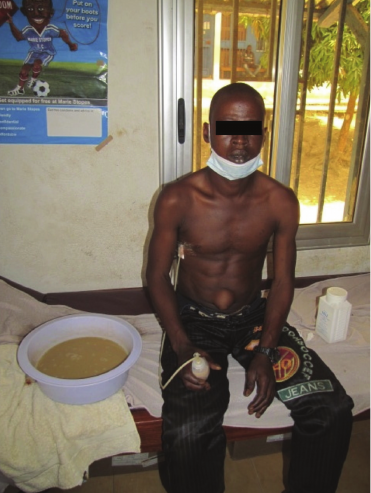
Figure 2: The patient after the JP drain was placed sitting next to approximately one-half of the empyema volume that was